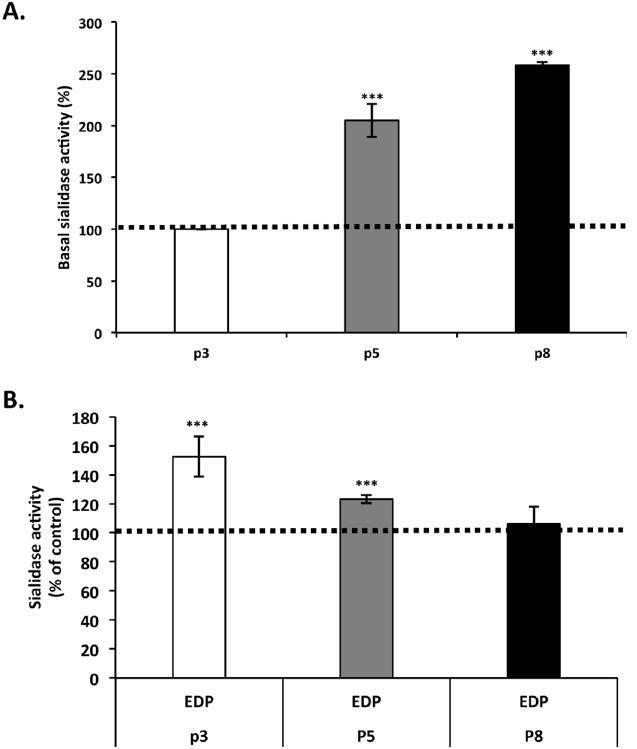
Fig 5. Impact of aging on EDP-induced sialidase activity. Young, intermediate and aged fibroblasts were represented by passage 3 (white), 5 (gray) and 8 (black bars). (A) Basal sialidase activity increases with age. Sialidase activity assay was performed on crude membrane using the chromogenic substrate para- nitrophenyl-NANA for 4 hours at 37°C. (B) EDP-mediated sialidase activity is altered with age. Cells were stimulated or not with 50 μ g/mL of EDP for 30 minutes then crude membrane were prepared and used to measure sialidase activity. Histogram represent the normalized results relative to the control expressed in percent. Each data is representative of three independent experiments. *** , p < 0.01. Dotted lines represent the values of the unstimulated